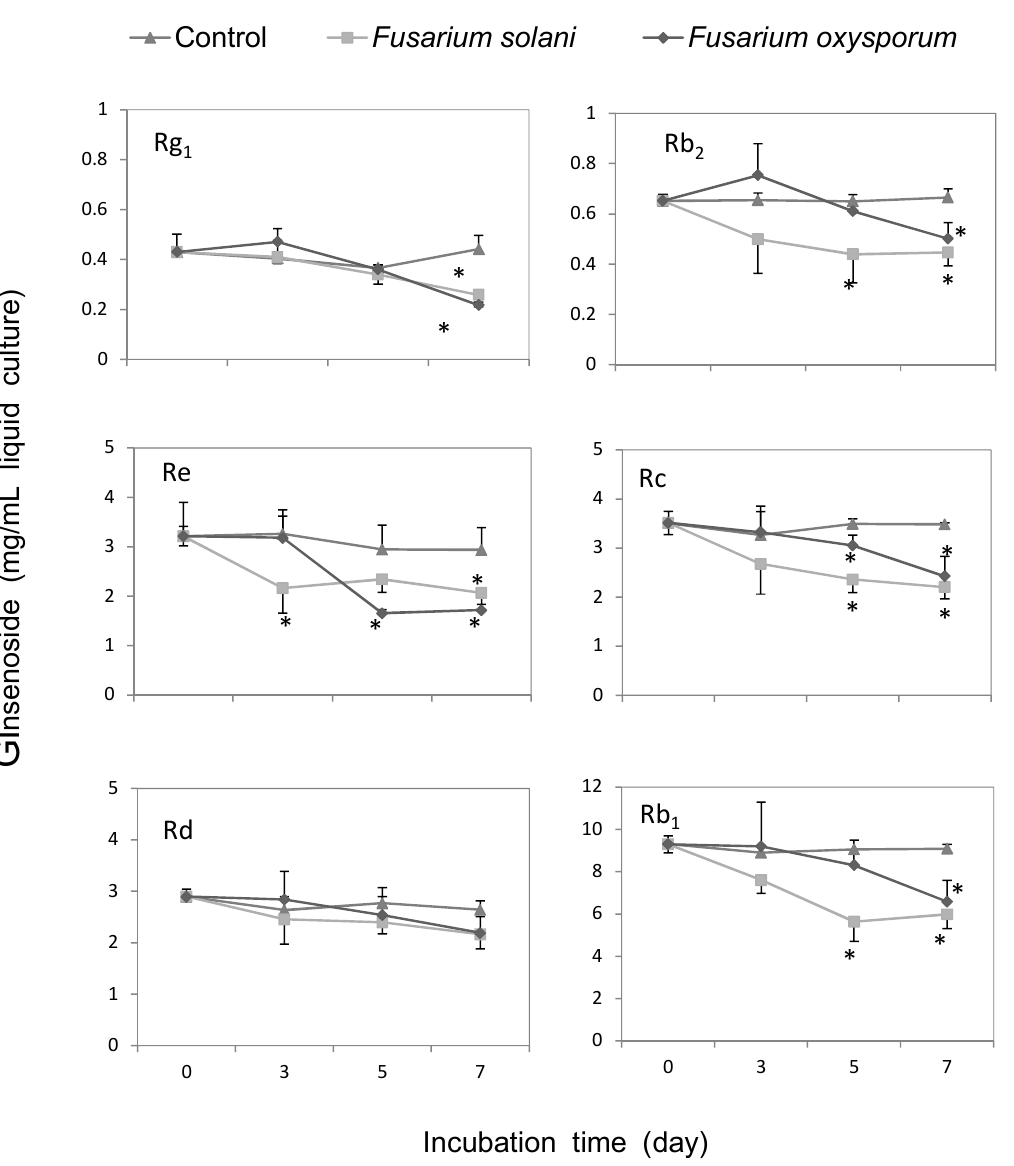
Figure 6. Metabolic effect of Fusarium solani and F. oxysporum on the concentrations of ginsenoside. Ginsenoside Rg , Rb , Re, Rc, Rd, and Rb , were incubated with F. solani 1 2 1 (square) or F. oxysporum (diamond) for 0 to 7 days. The values of ginsenoside content followed by an asterisk indicate a significant difference with control group (trilateral) at α = 0.05 ( p < 0.05), as analyzed using Fisher’s least significant difference (LSD)